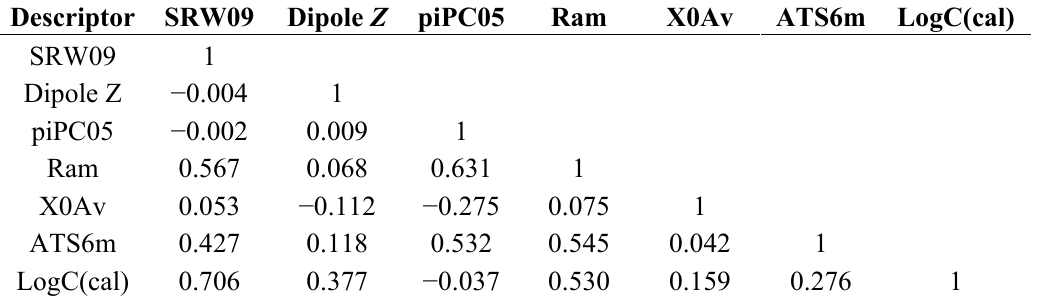
Table 2. Correlation matrix for physicochemical, 2D-3D descriptors and LogC(cal) used in the